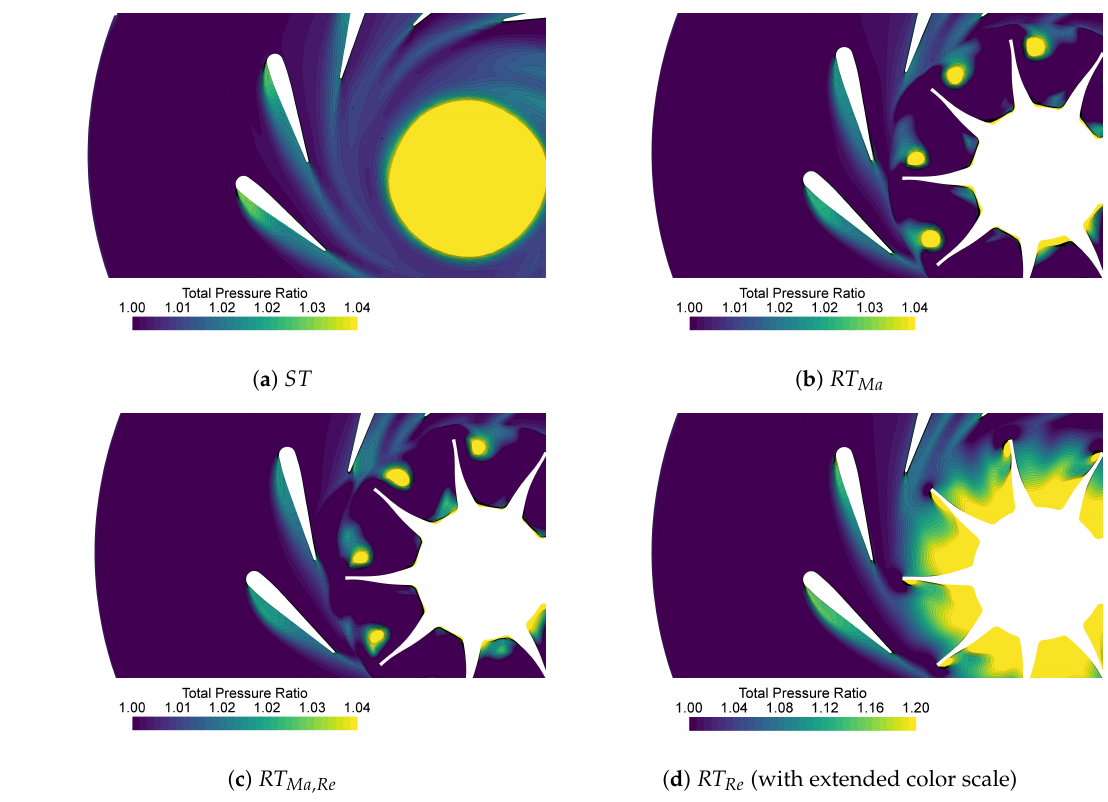
Figure 8. Local total pressure ratio p tot , inlet